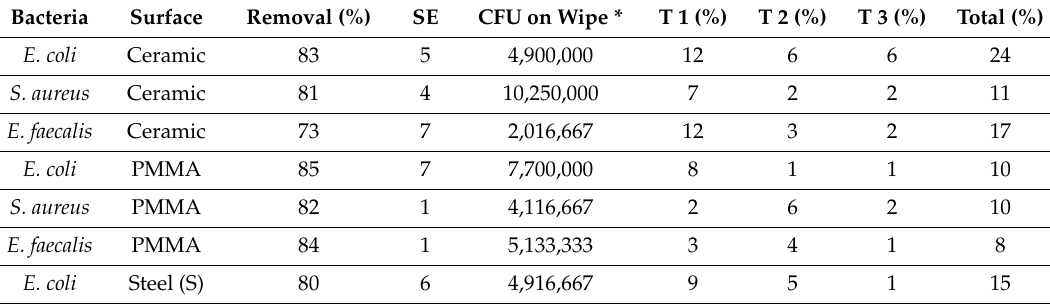
Table 4. Removal of bacteria and recontamination of surfaces by a 100% Lyocell nonwoven wipe. Steel (R) denotes rough steel samples. Steel (S) denotes smooth steel